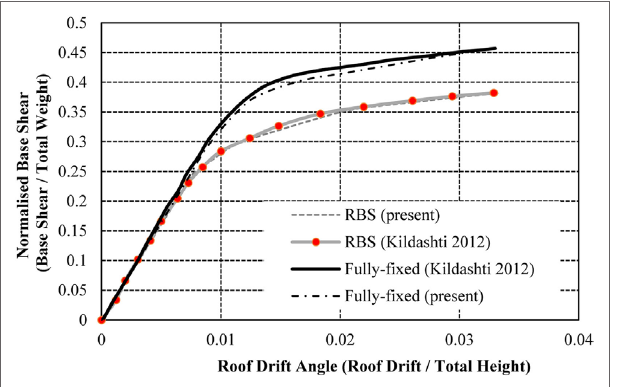
Figure 9 | 16-storey frame normalized capacity curve validation.